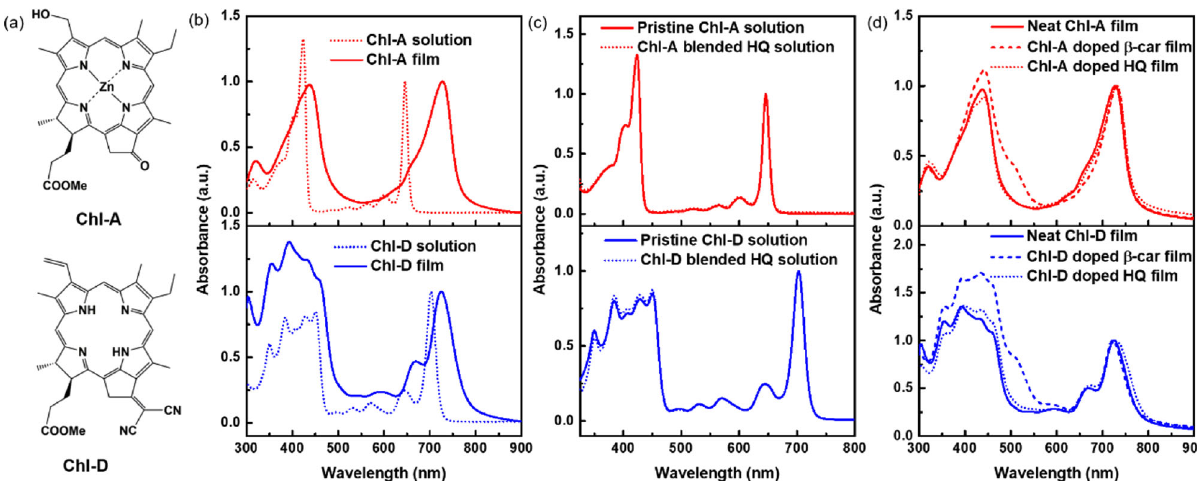
Fig. 1 Chemical structures and steady-state absorption spectra of Chl-A and Chl-D. a Chemical structures of Chl-A and Chl-D, ( b ) their steady-state absorption spectra in THF and in the fi lm states, ( c ) solution samples with and without blending with HQ, and ( d ) fi lm samples with and without blending all- trans - β -carotene or HQ. Note that all the data are normalized at their Q y